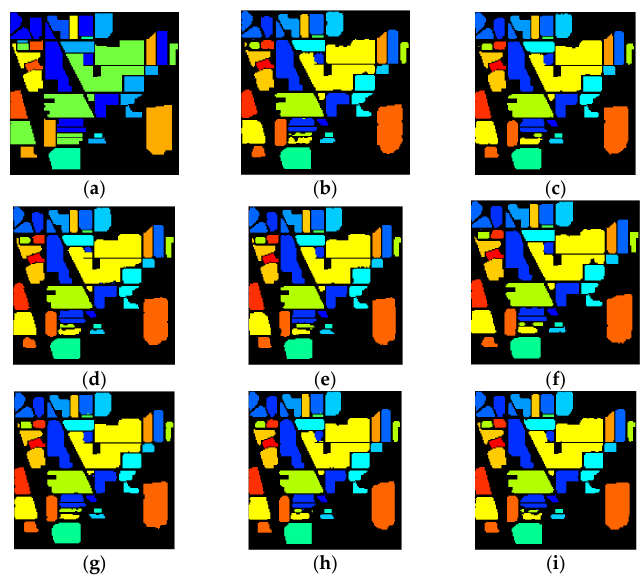
Figure 4. Classification maps produced by iterative LCMV (ILCMV) for Purdue’s data using bands selected in Table 2. ( a ) Ground truth, ( b ) Full bands, ( c ) UBS, ( d ) MEAC, ( e ) MDPP, ( f ) DSEBS, ( g ) SQ LCMV-BSS-1, ( h ) SQ LCMV-BSS-2, ( i ) SC LCMV-BSS.